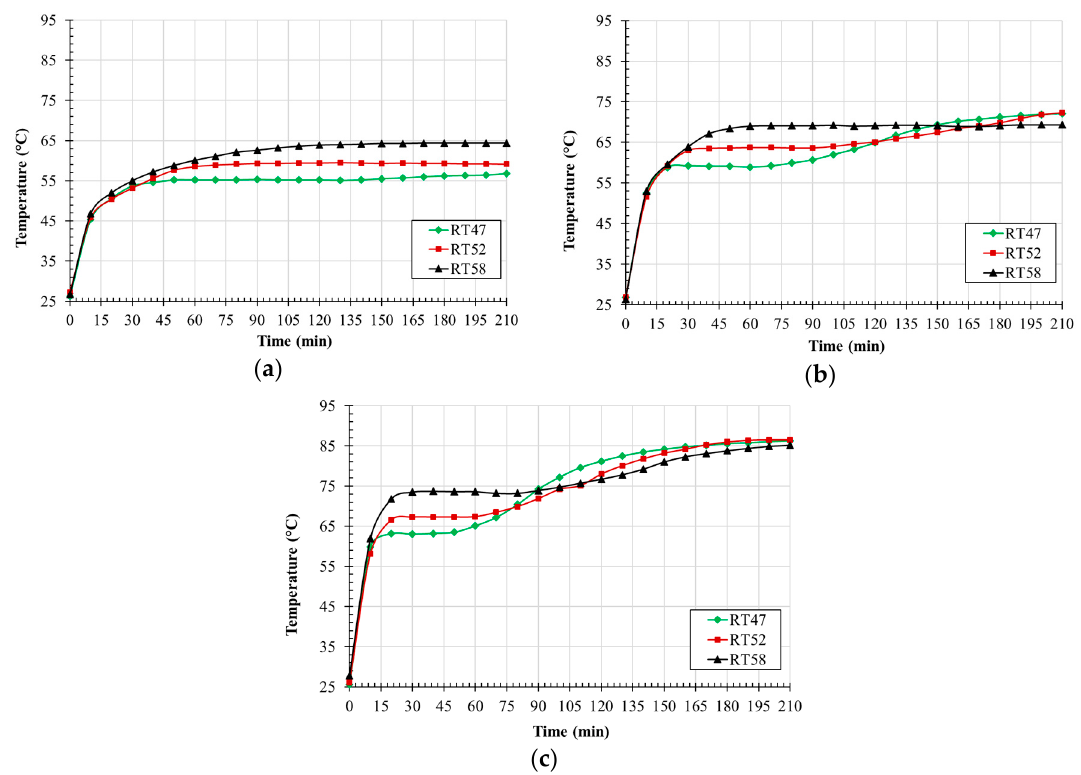
Figure 7. Surface temperature for heat sink A at power rating, ( a ) 1.0 W, ( b ) 1.5 W and ( c ) 2.0 W.